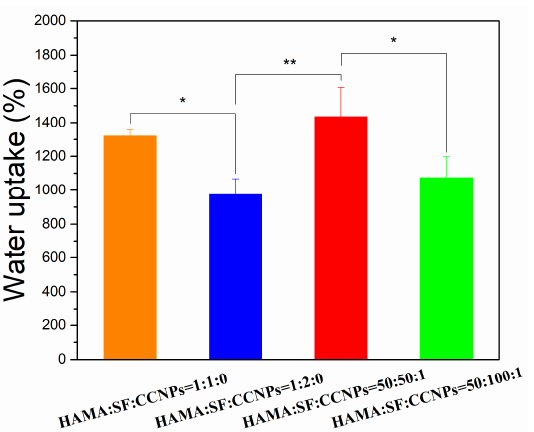
Figure 4. Pore size of CCNPs-SF/HAMA hydrogels *** p < 0.001 are differences between the indicated groups.